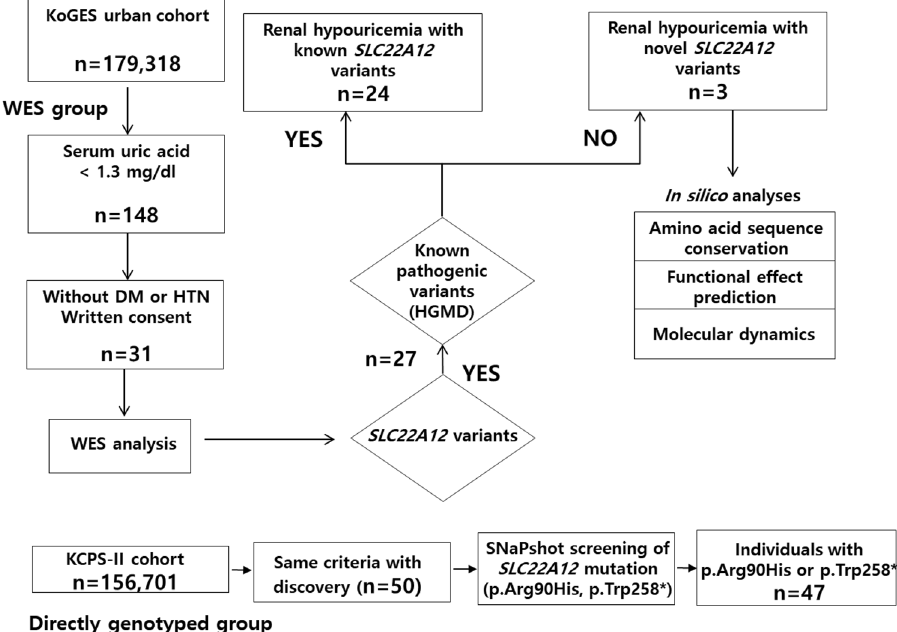
Figure 1. Overall flowchart for investigating novel variants associated with renal hypouricemia (DM: Diabetes Mellitus, HTN: Hypertension).